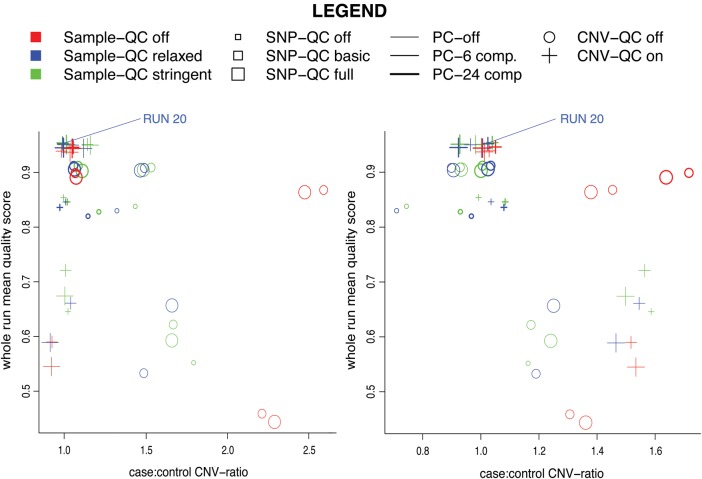
Quality score versus global burden ratio. From 54 runs of the pipeline with systematically differing QC configurations, this figure shows quality scores (average confidence percentage) versus global case–control ratio of the resulting set of CNVs called for rDELs (left) and rDUPs (right), respectively. See detailed legend for the meanings of the colour (Sample QC), size (SNP-QC), thickness (PC-correction) and shape (CNV-QC) of the points in the plot. It can be seen that there is an association of higher quality scores with a burden ratio nearer to 1.0. PC-correction (line thickness) has the largest magnitude of effect. All comparisons were made using rDELs/rDUPs inferred by at least six SNP sites. The Supplementary Material, Methods S3 contains information on how the number of sites we used was chosen.